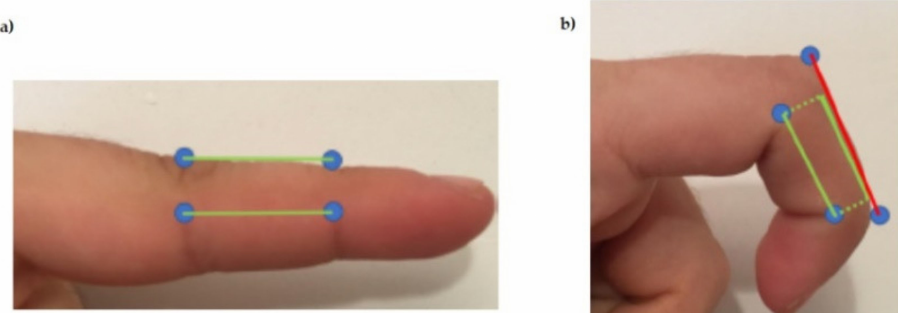
Figure 3. ( a ) Finger fully stretched (minimum distance between upper joint area). ( b ) Bent finger (maximum distance between the upper part of the joints).